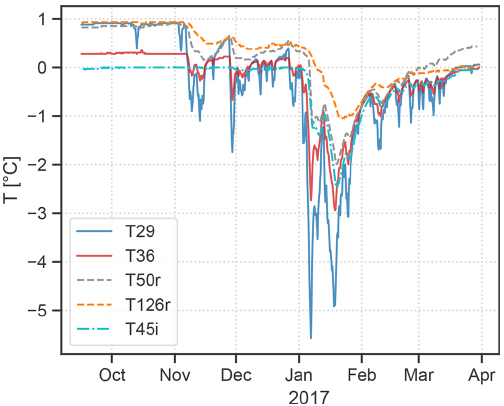
Figure 9. Time series of cave air temperature (T29, T36), rock tem- perature at 50 and 126cm (T50r and T126r) measured in Eisdom, and ice temperature at 45cm depth at the rock–ice interface (T45i) measured close to Tiefster Punkt for the period 16 September 2016 to 30 March 2017 (the only period with parallel measurements of all loggers mentioned